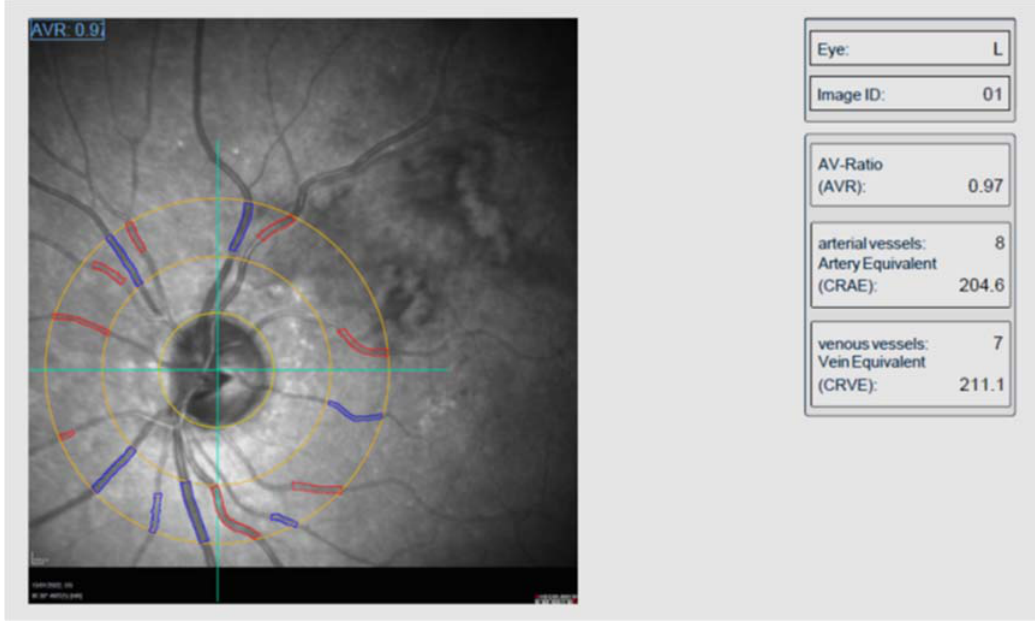
Figure 1. Retinal vessel calibers analysis using Vesselmap 2 software. Arterioles and venules are spread around the outer circle.